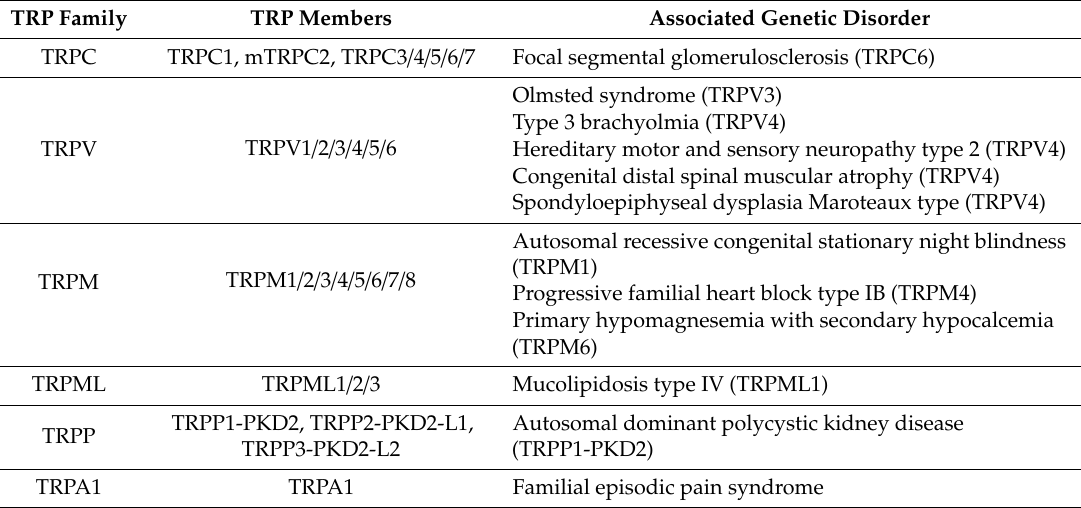
Table 2. TRP channels and associated genetic